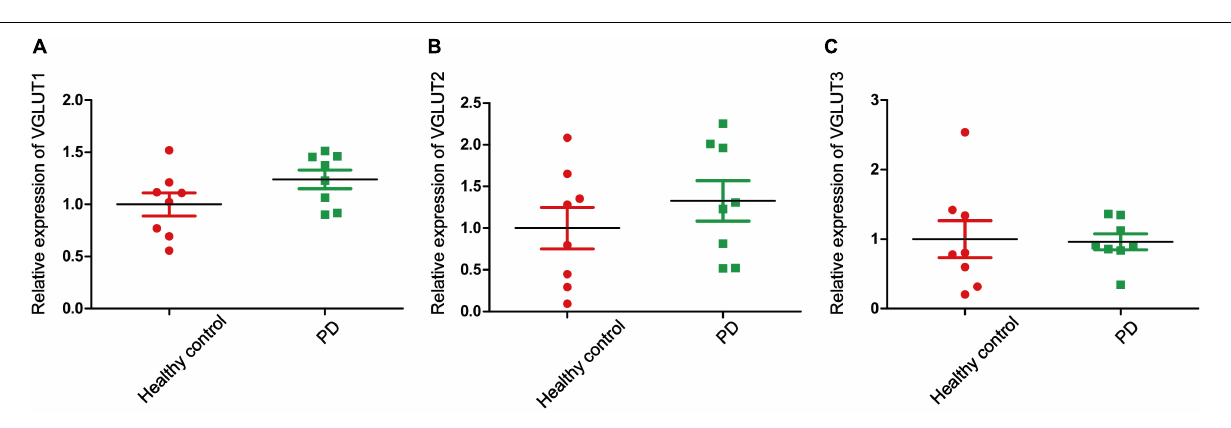
Frontiers in Neuroscience |